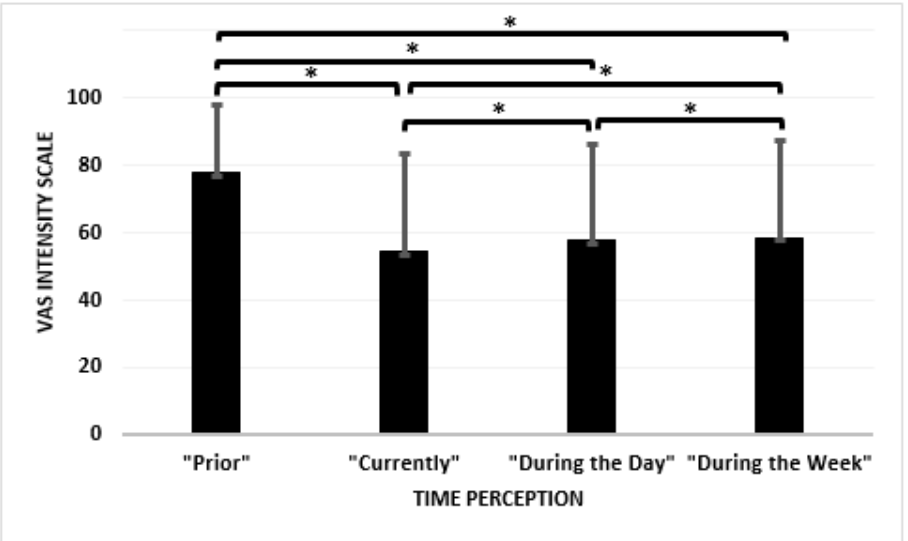
Figure 2. Bar chart description showing the perception of time based on the VAS intensity scale where time perception is measured from a scale from 1 to 100 and interpreted from “time seems to go slowly” to “time flies very fast”. * indicates significance between variables.